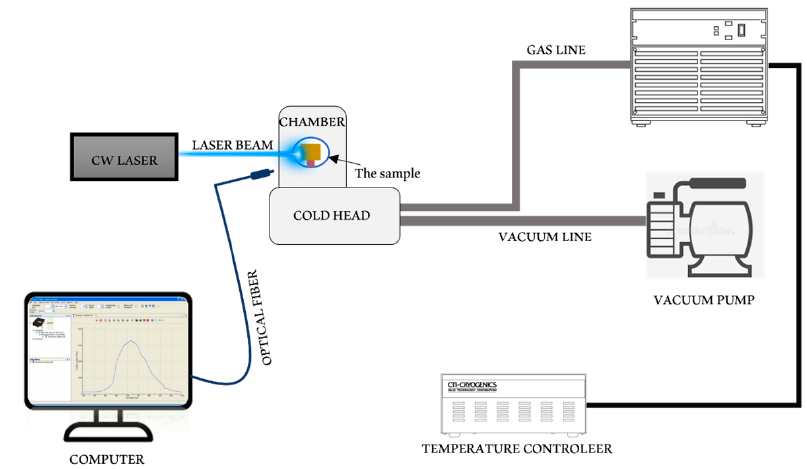
Figure 2. Schematic diagram of the low-temperature measurements setup.